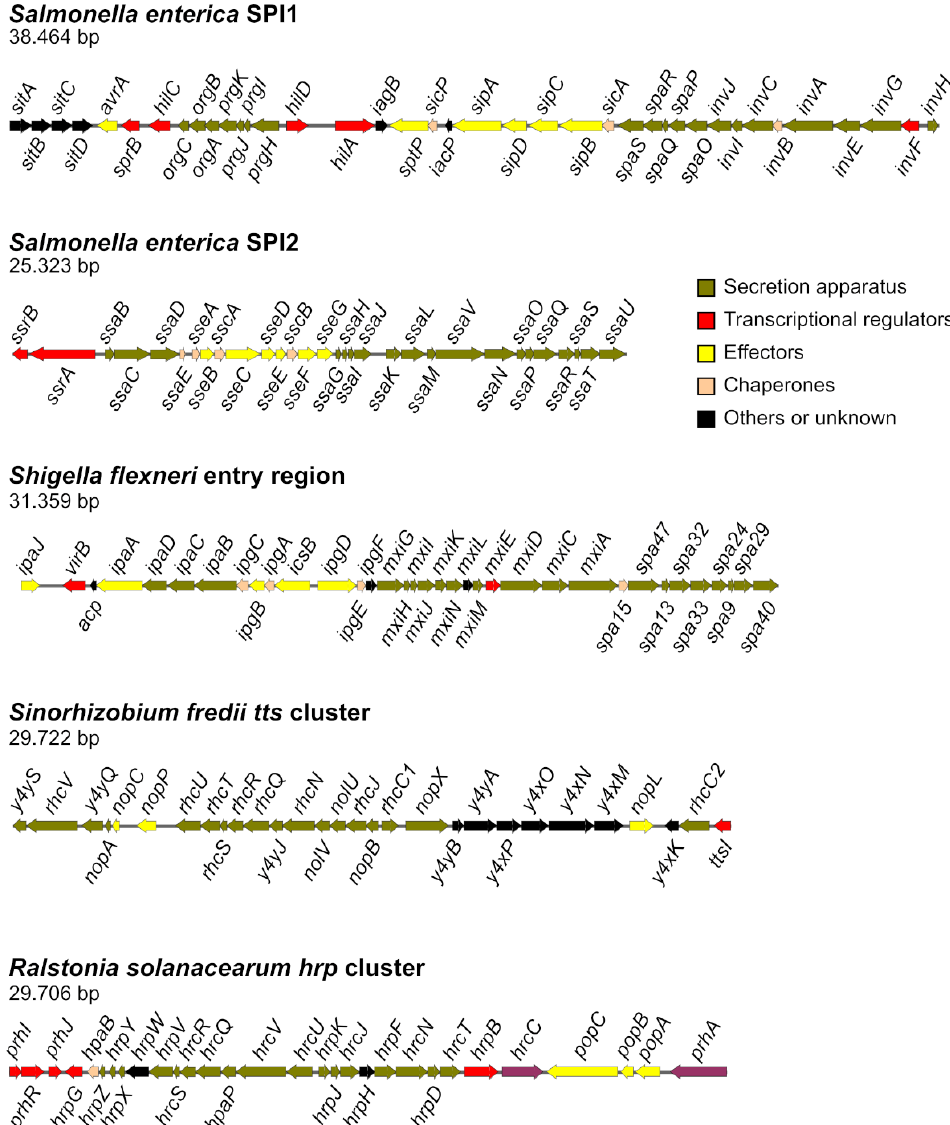
Figure 1. Clusters of genes that encode T3SSs. SPI1 and SPI2 from S. enterica serovar Typhimurium, the entry region from S. flexneri , the tts cluster from S. fredii , and the hrp cluster from R. solanacearum .